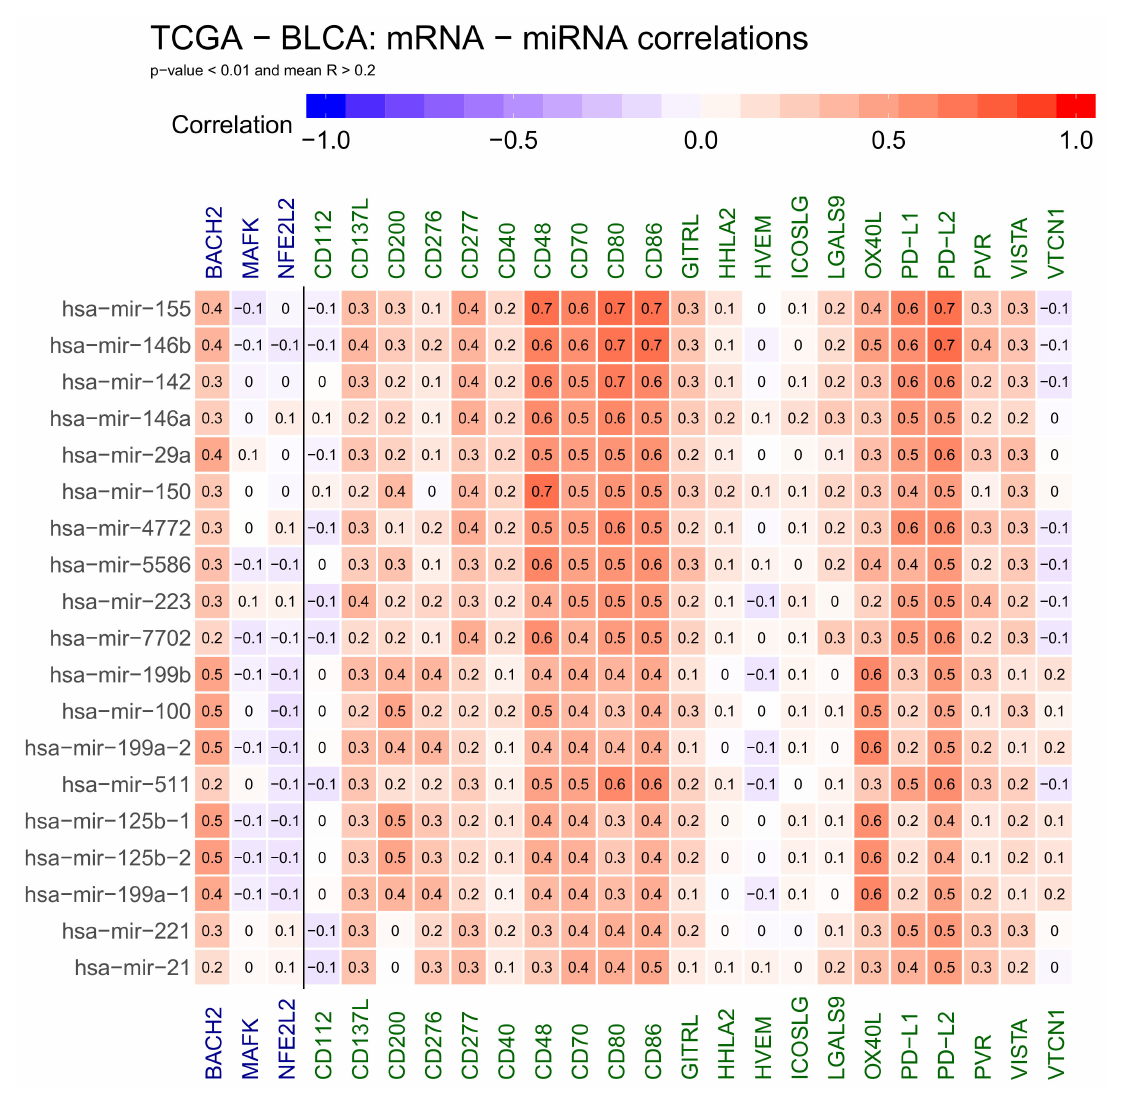
Figure 2. Heatmap showing positive correlations between selected genes active at cancer side of the immunological synapse: CD112, CD137L, CD200, CD276, CD277, CD40, CD48, CD70, CD80, CD86, GITRL, HHLA2, HVEM, ICOSLG, LGALS9, OX40L, PD − L1, PD − L2, PVR, VISTA and VTCN1, transcription factors: BACH2, MAFK and NFE2L2 and miRNA. Positive correlations are shown in red. The numbers in heatmap tiles represent the correlation coefficient. The following statistical criteria were used to filter miRNA: correlation coefficient >= 0.2 for correlated microRNAs and statistical significance of correlation ( p -value from cor.test function in R) <